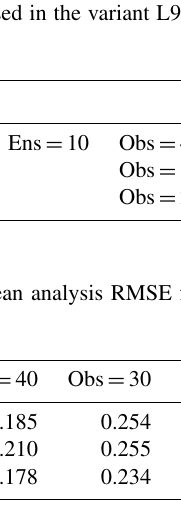
Figure 5. The true (black) and localized background error covariances ( ρ X b X T first and (b) the second DA cycles, and for the variant L96 model at (c) the first and (d) the second DA cycles. The localization functions and configurations are the same as in Fig. 3.